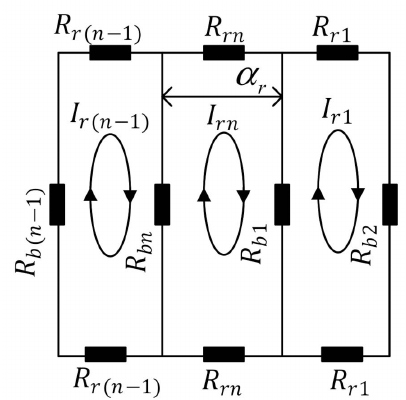
Figure 5. Diagram of single-turn squirrel cage rotor